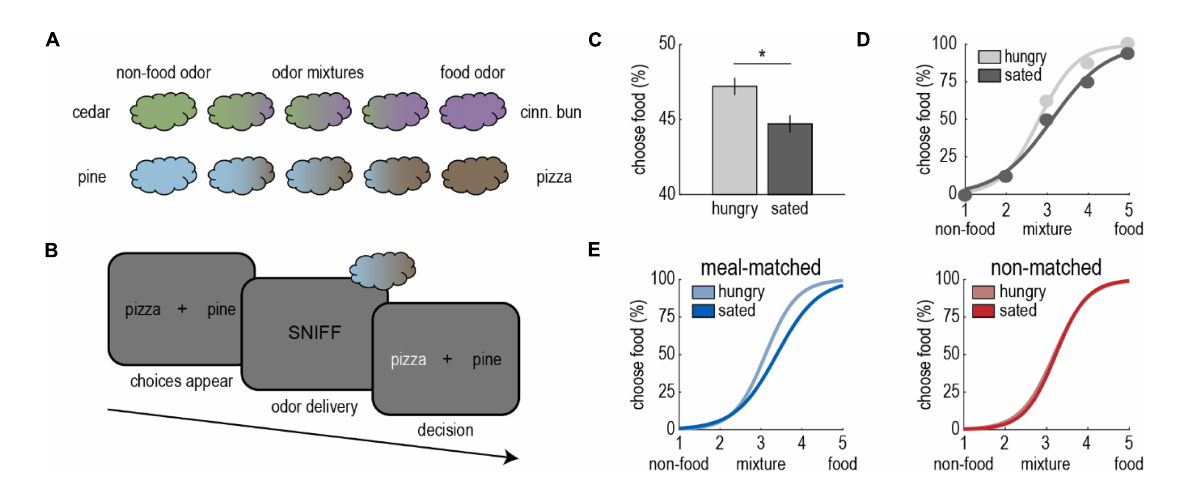
FIGURE1 Satiety state modulates olfactory perceptual decision-making. (A) Olfactory stimuli included cedar, cinnamon bun, pine, and pizza odors, as well as non-food/food odor mixtures (cedar/cinnamon bun, pine/pizza). (B) On each trial of the olfactory decision-making task, participants indicated whether they perceived the odor to be food-dominant or non-food-dominant. They completed the task in the hungry state, and then again after a meal of cinnamon buns or pizza. (C) Participants were more likely to perceive odors as food-dominant in the hungry state. (D) Sigmoidal functions were fitted to each participants’ choice data for meal-matched and non-matched odor pairs separately. The figure depicts a single participant’s average perceptual choices and fitted choice curves for the meal-matched odor pair. (E) After the meal, participants’ perceptual choice curves shifted toward the food odor, but only for the meal-matched odor pair. In more specific terms, after eating a meal of cinnamon buns, more cinnamon bun odor was required in cedar/cinnamon bun mixtures for participants to perceive them as food-dominant, while pine/pizza mixtures were unaffected, and the opposite was true after a meal of pizza. Adapted from Shanahan et al.